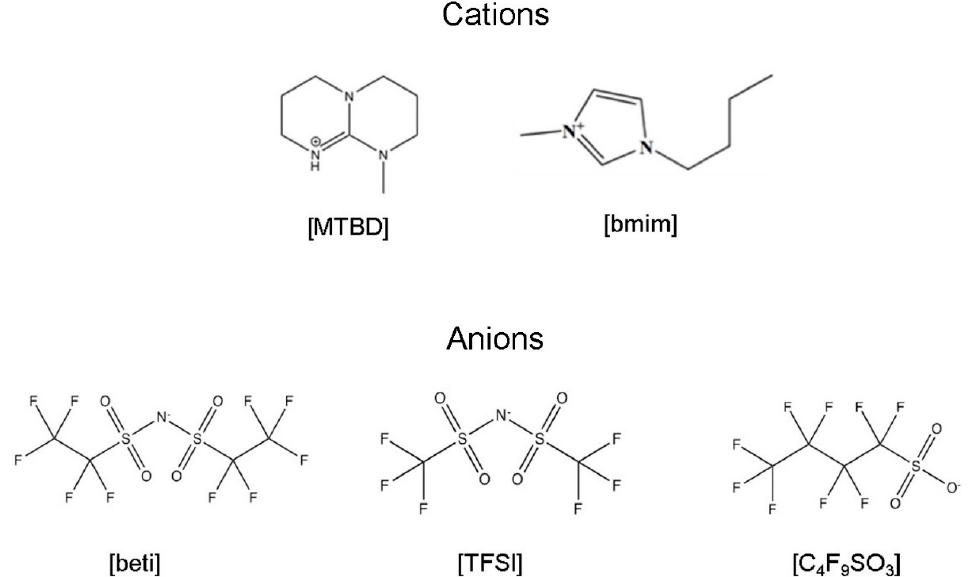
Figure 1. Chemical structure of the IL anions and cations studied in this work.